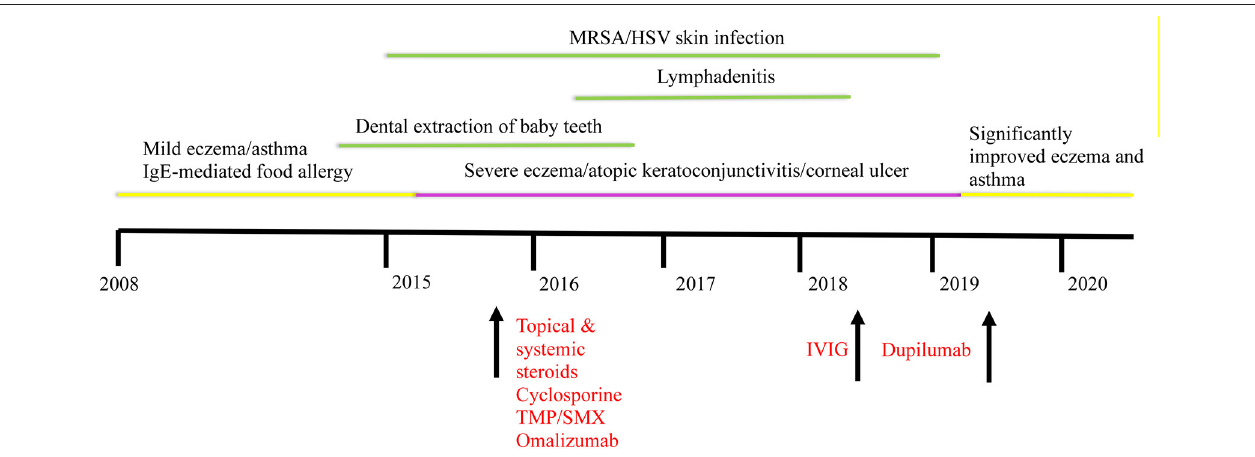
FIGURE 2 | Timeline illustrating the development of our patient’s clinical phenotype and improvement following dupilumab. Interventions are indicated in red. HSV, herpes simplex virus; IgE, immunoglobulin E; IVIG, intravenous immunoglobulin; MRSA, methicillin resistant Staphylococcus aureus ; TMP/SMX,